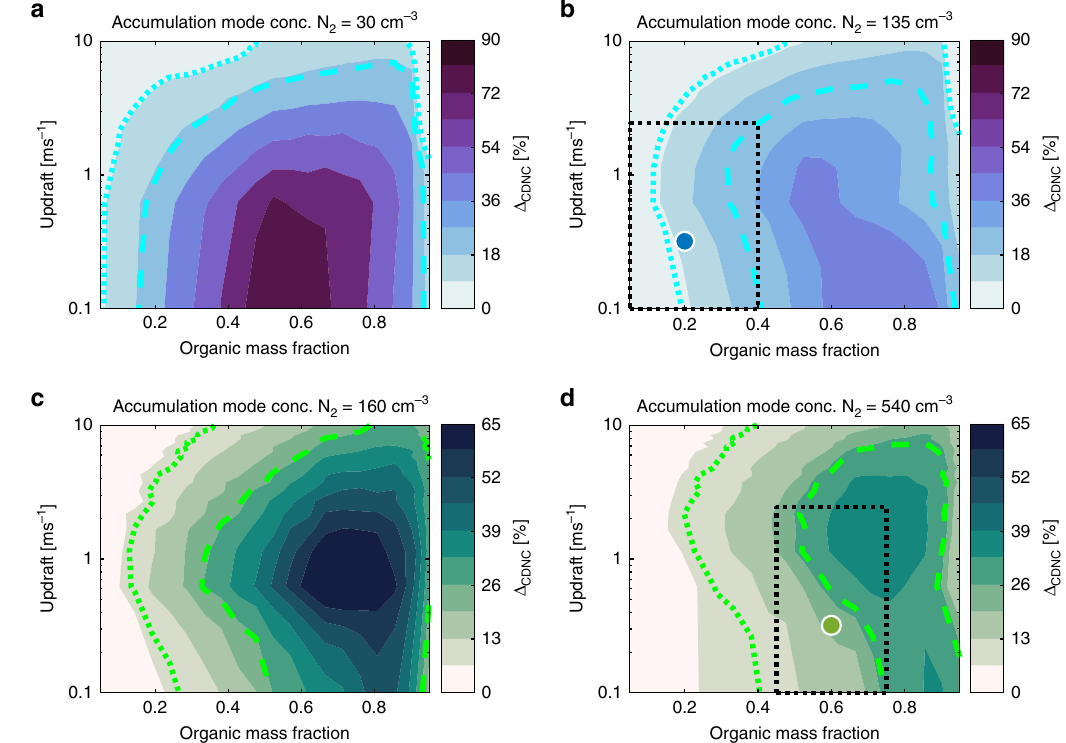
Fig. 3 Cloud droplet number concentration response Δ CDNC to the surface phase as a function of organic mass fraction and parcel updraft velocity. Δ CDNC at 200 m above cloud base, as a function of the fi xed updraft velocity and organic mass fraction for: a , b Marine (MA) simulations setting accumulation mode concentrations N 2 = 30 cm − 3 (corresponding to pristine marine accumulation mode, as observed during the NUM event 16 ) and N 2 = 135 cm − 3 , respectively. c – d Boreal (HYY) with N 2 = 160 cm − 3 and N 2 = 540 cm − 3 , respectively. Blue and green markers indicate base MA and HYY simulation cases. Dotted boxes outline the regions of the parameter planes associated with typical environmental conditions (Table 2). Accumulation mode concentrations N 2 in panels a and c correspond to lower bounds for the studied environments 16,31 , and those in b and d to average values. Dotted curves show the Δ CDNC = 10% isoline. Dashed curves illustrate the environment speci fi c Δ = 5% isolines, i.e., Δ = 25, and 28%, respectively for MA and HYY, determined α CDNC from the Schwartz and Slingo approximation 64